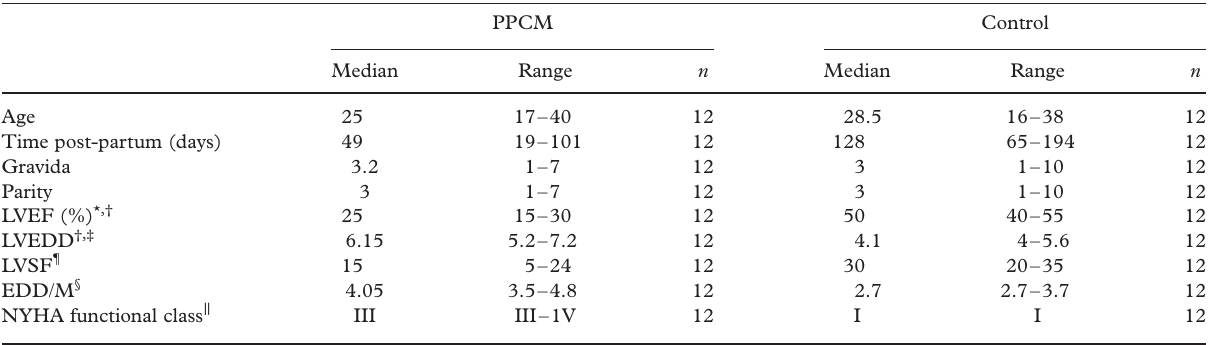
Table I. Baseline clinical data on PPCM and control